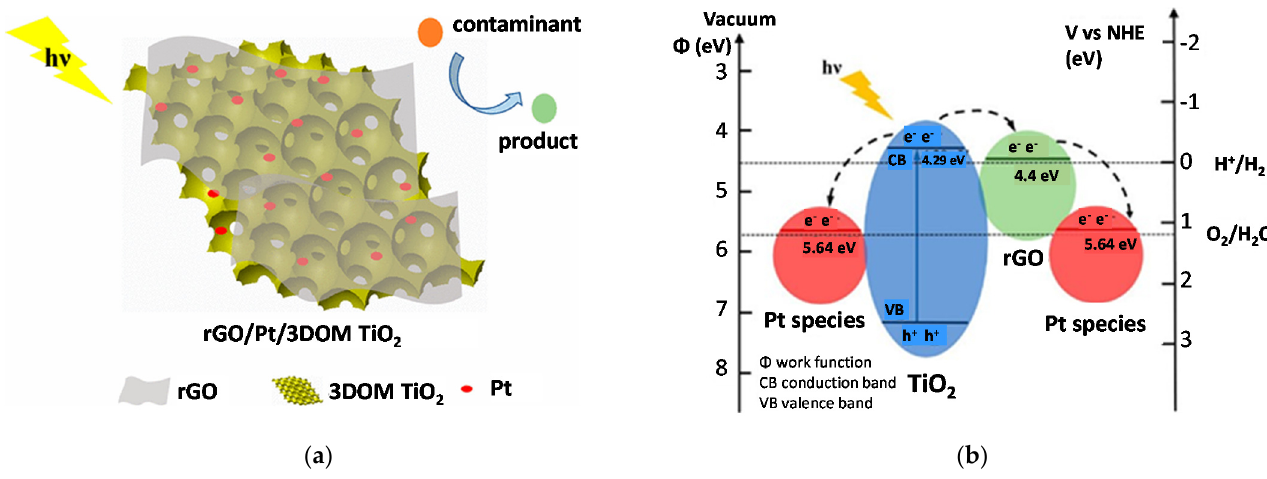
Figure 11. Schematic illustrations of: ( a ) the morphology of TiO 2 IO co-modified with Pt NPs and reduced graphene oxide (r-GO), and ( b ) the proposed charge carriers’ separation and migration in rGO/Pt/TiO 2 (not plasmonic activation), rGO-green, Pt-red, TiO 2 -blue; Reprinted with permission from [68]. Copyright (2019) ACS.